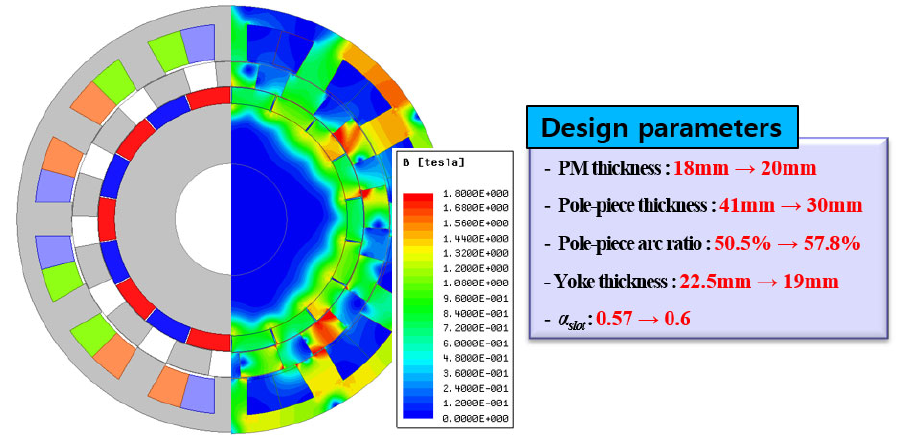
Figure 11. Final design model and magnetic flux density distribution of the 45kW ‐ class MG ‐ PMSM with a concentrated winding.